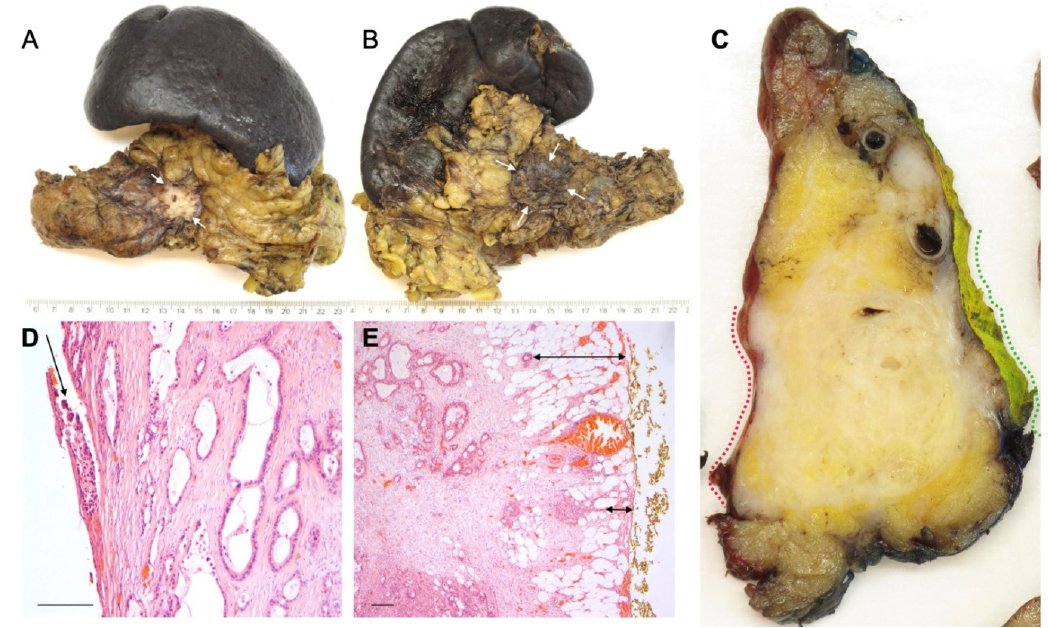
Figure 3. Involvement of the anterior pancreatic surface and Gerota’s fascia by this large tumour in the pancreatic body is suspected macroscopically, both on external inspection (( A ) anterior surface, arrows , and ( B ) posterior surface with Gerota’s fascia, arrows ) and on a sagittal specimen slice (( C ) anterior surface and Gerota’s fascia , red and green dotted lines , respectively). Histology confirms tumour breaching of the anterior surface (( D ) arrow ) and infiltration within 1 mm of the posterior surface of Gerota’s fascia (( E ) arrows ). Magnification: 400× ( D ), 200× ( E ). Scale bar ( D , E ): 200 microns.